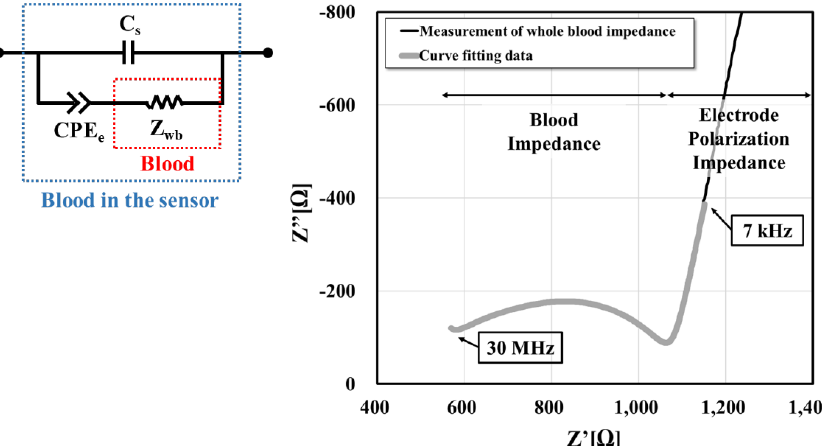
Figure 2. Curve fitting data with an electrical equivalent circuit. Curve fitting was performed using an equivalent circuit to extract the electrical properties of the blood from the measured impedances. For the impedance fitting, the 7 kHz to 30 MHz range of the impedance graph was used in the temperature dependence